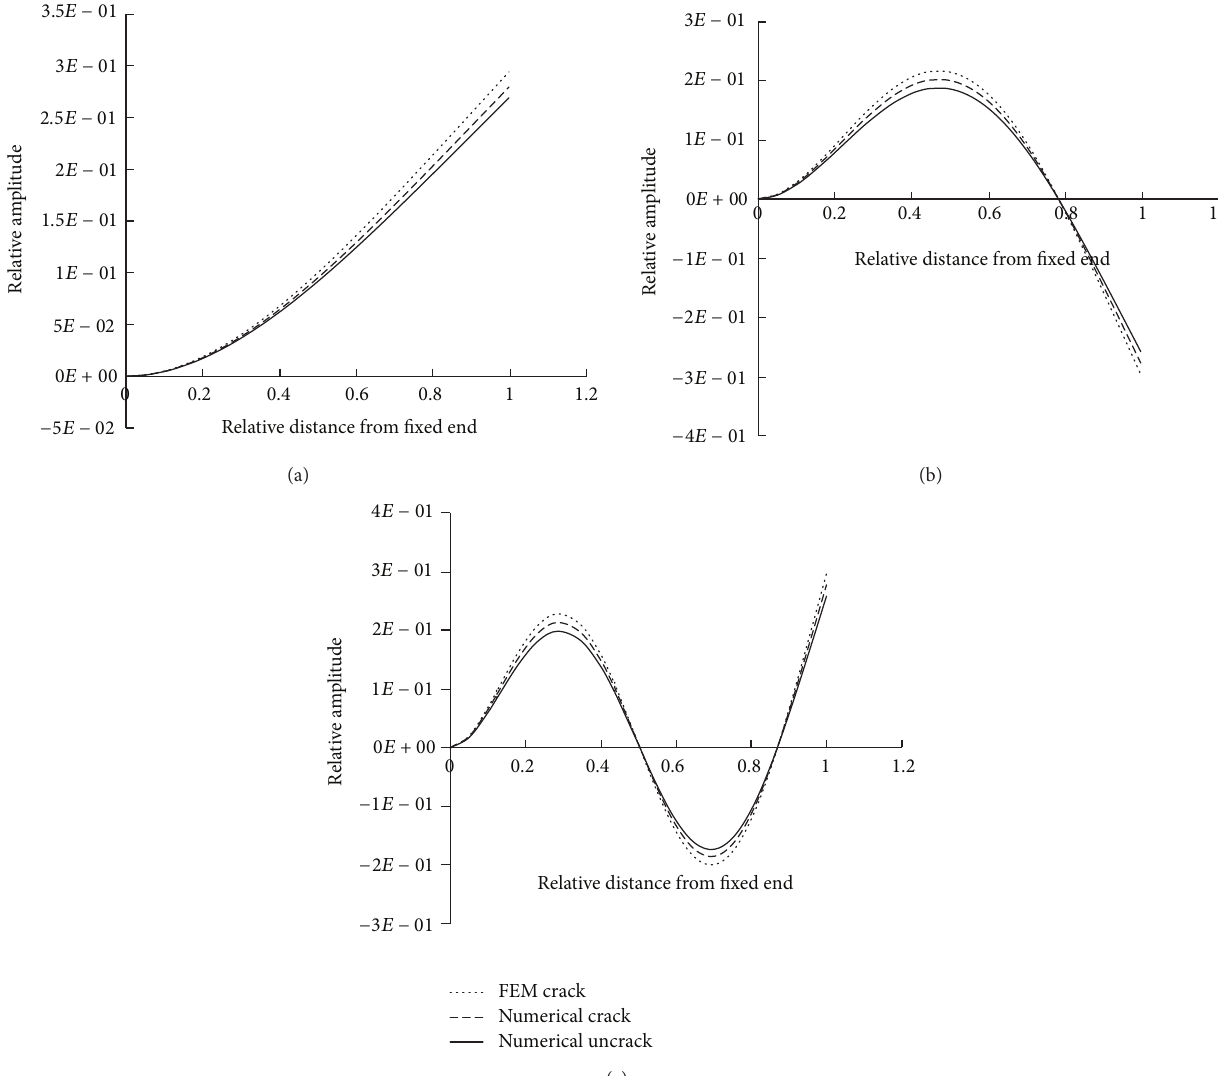
/𝑊 = 0.0833 , 𝑎 /𝑊 = 1 2 /𝑊 = 0.0833 , 1